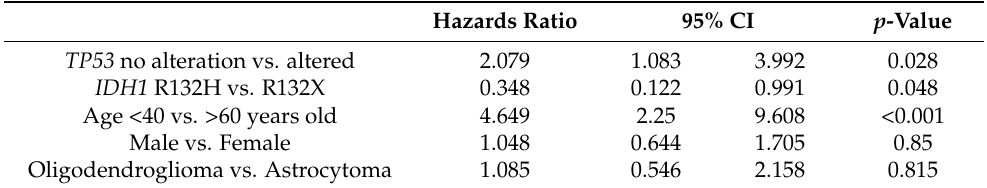
Table 6. Multivariate Cox proportional hazards analysis of TP53 status in the IDH1 hotspot mutation subgroup of TCGA-LGG dataset. Table 7. Multivariate Cox proportional hazards analysis of TP53 status in the oligodendroglioma subgroup of TCGA-LGG